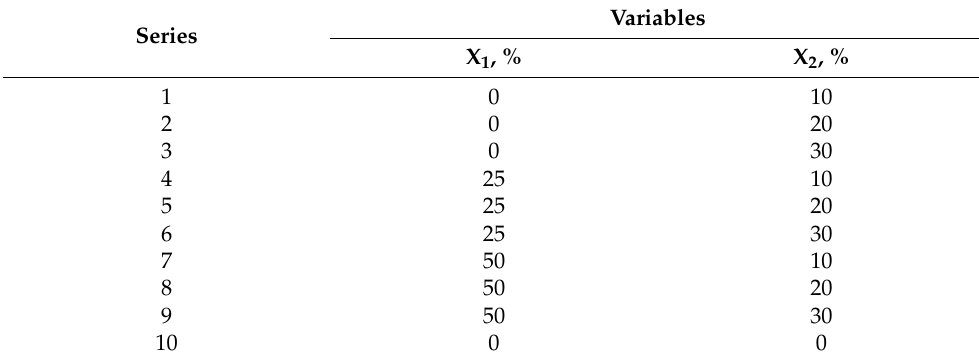
Table 5. The experimental plan.